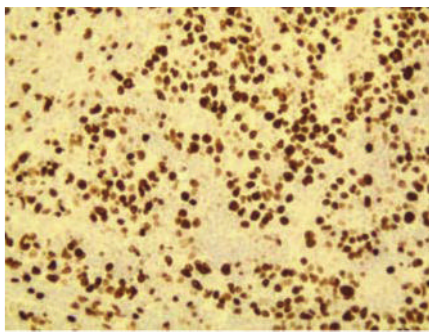
Figure 11: Ki-67 positivity index of malignancy